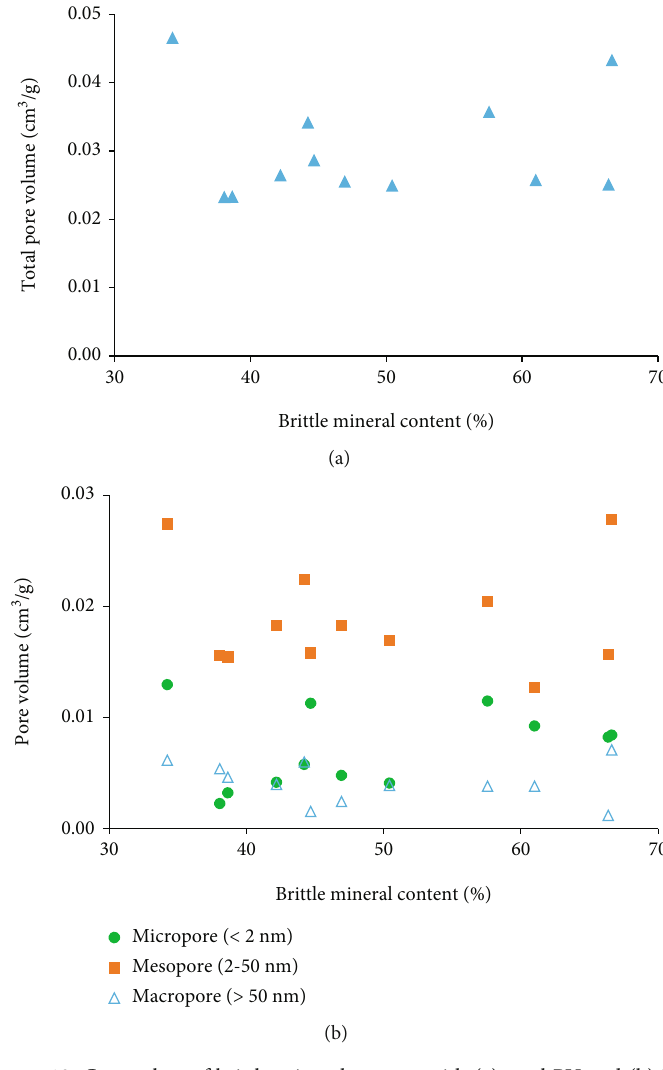
Figure 10: Cross-plots of brittle mineral content with (a) total PV and (b)